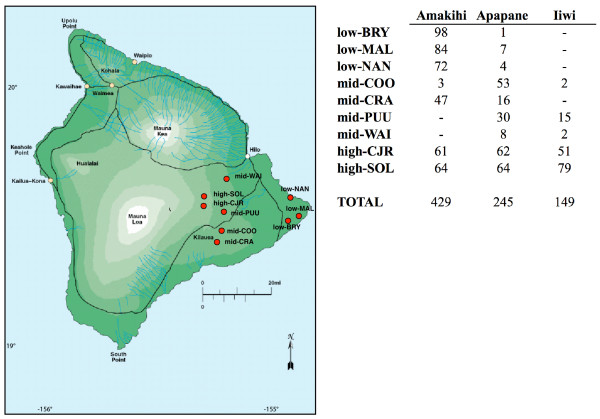
Honeycreeper samples included in this study. Samples were collected at nine sampling locations on the eastern slopes of the Mauna Loa and Kilauea volcanoes of the island of Hawaii. Low elevation (< 300 m above sea level) sites include Bryson's Cinder Cone (low-BRY), Malama Ki Forest Reserve (low-MAL), and Nanawale Forest Reserve (low-NAN). Mid elevation sites (between 1,000 and 1,300 m above sea level) include Cooper's (mid-COO), Crater Rim (mid-CRA), Pu'u Unit (mid-PUU), and Waiakea Forest Preserve (mid-WAI). High elevation sites (more than 1,650 m above sea level) include C. J. Ralph (high-CJR) and Solomon's (high-SOL). The numbers of samples of each species collected at each site are shown.